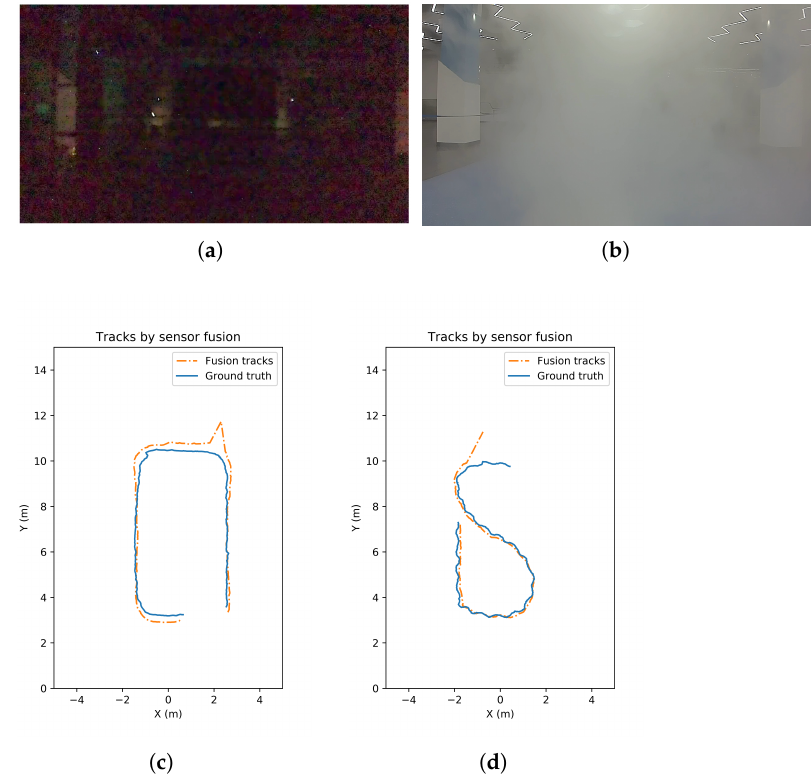
Figure 10. Camera-challenging scenarios and fusion tracking results. ( a ) Camera captures under bad illumination. ( b ) Camera captures in foggy environment. ( c ) Tracking results under bad illumination. ( d ) Tracking results under foggy